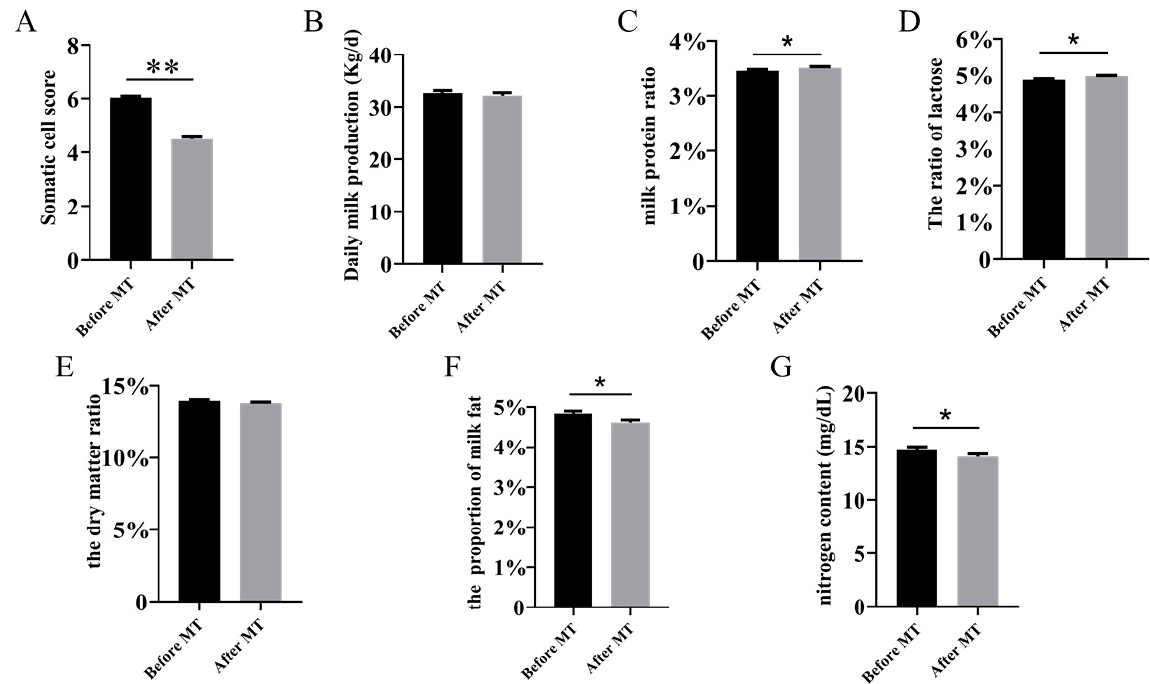
Figure 1. Influence of the melatonin application on the Dairy Herd Improvement (DHI). ( A ) Somatic cell score, ( B ) milk yield, ( C ) protein content, ( D ) lactose content, ( E ) fat content, ( F ) dry matter content and ( G ) urea nitrogen content. All data are represented by the mean ± standard error, * p < 0.05, ** p < 0.01, n = 328. MT: melatonin.